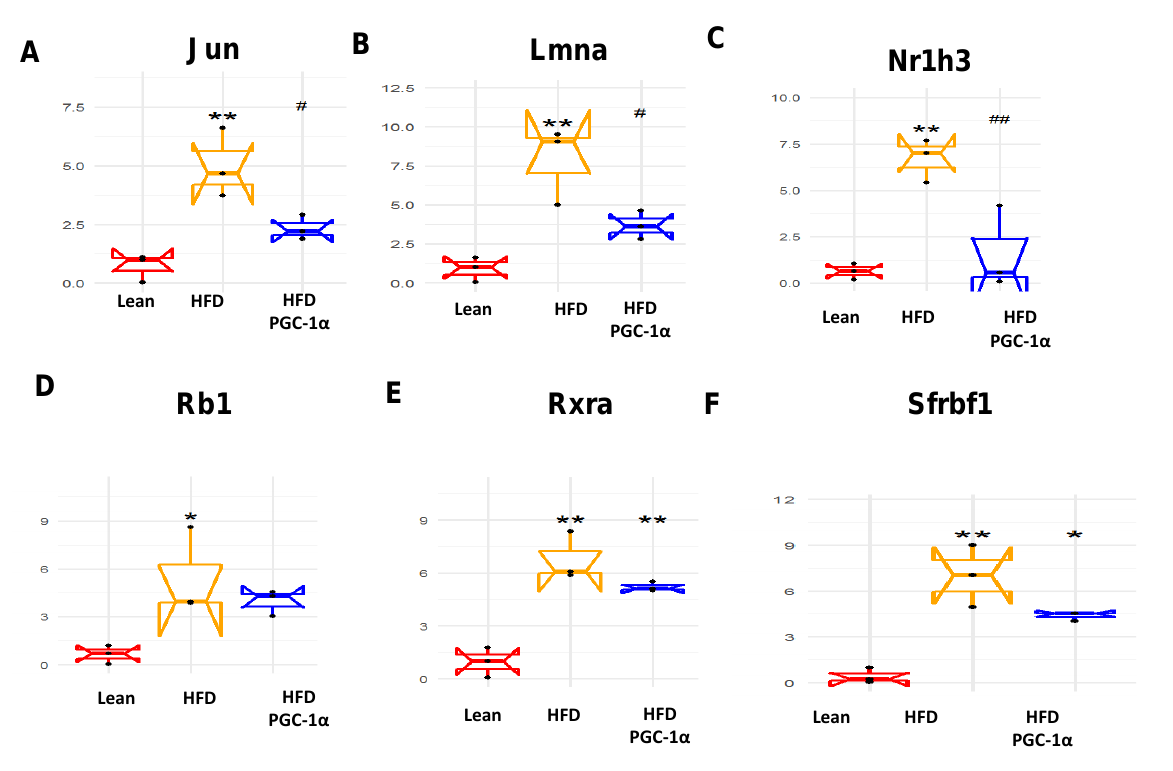
Figure 6. The mRNA expression of ( A ) Jun proto-oncogene (Jun), ( B ) lamin A (Lmna), ( C ) nuclear receptor subfamily 1 group H member 3 (Nr1h3), ( D ) R.B. transcriptional corepressor 1 (Rb1), ( E ) retinoid X receptor alpha (Rxra), and ( F ) secreted frizzled-related protein 1 (Sfrbf1) in the adipose tissue of lean, high-fat-diet (H.F.D.)-fed and Transgenic-adipo-PGC-1 α mice. Data are expressed as mean ± S.E.M. ( n = 5); * p < 0.05, ** p < 0.005 vs. lean; # p < 0.05, ## p < 0.005 vs. HFD.